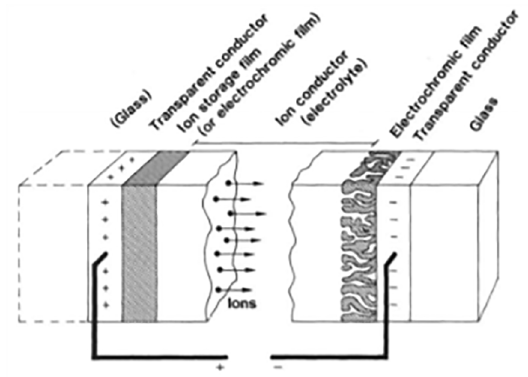
Figure 1. Basic design of an electrochromic device